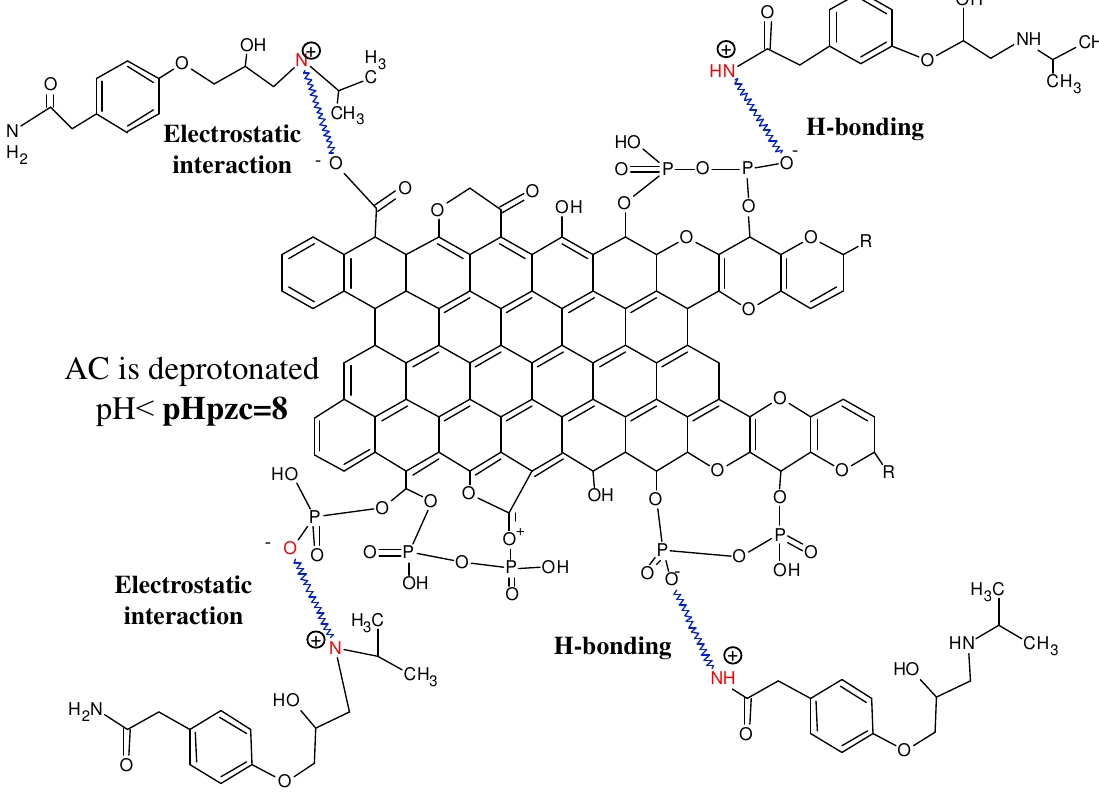
Figure 5. Adsorption mechanism of atenolol on activated carbon.